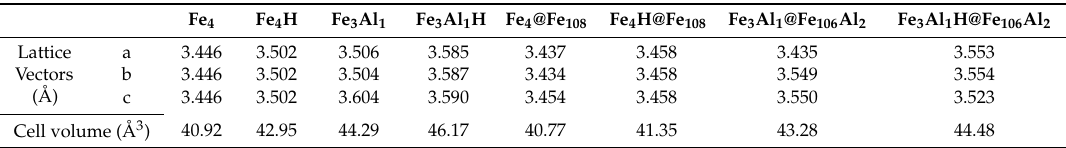
Table 2. The lattice parameters and volume of Fe 4 and Fe 3 Al 1 nit cells.